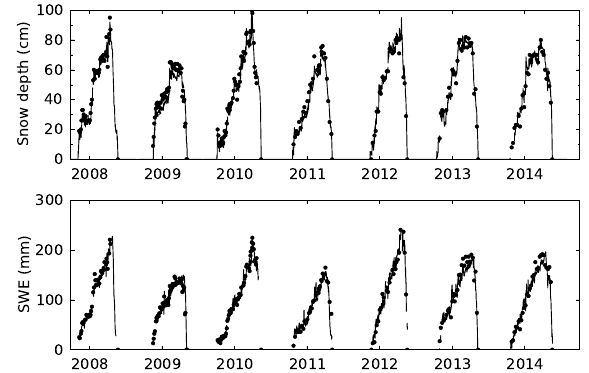
Figure 5. Measured snow depth and SWE from manual measure- ments (dots) and automatic instruments (lines). Daily averages of the automatic SWE measurements are used to reduce noise.